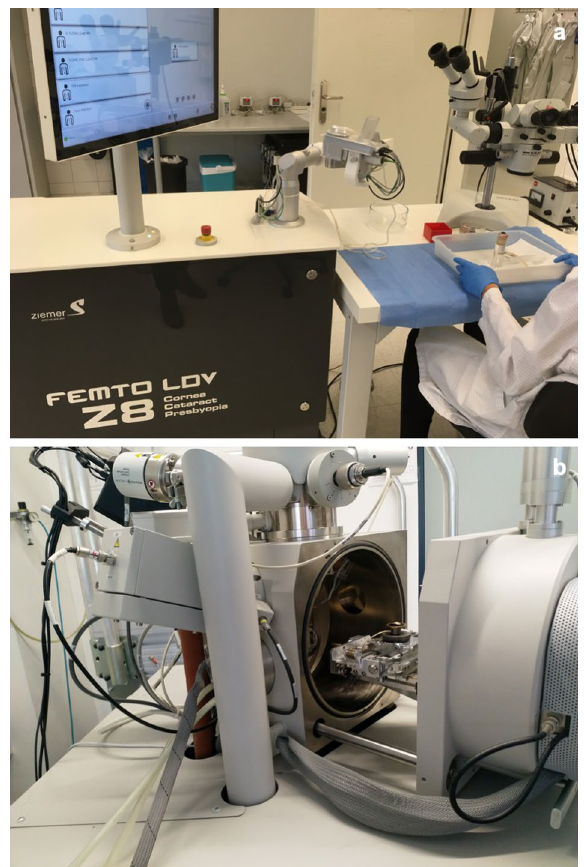
Figure 1. ( a ) Standardised lab set up for ex-vivo porcine eye surgeries. (Permission obtained from Ziemer AG, Switzerland for displaying the brand logo). ( b ) Porcine cornea mounting on the Scanning Electron